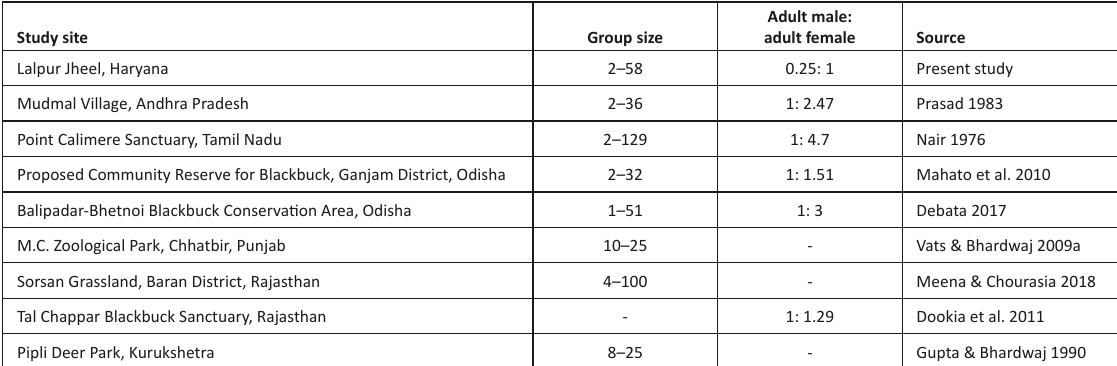
Table 5. Group size and sex ratio of Blackbuck Antilope cervicapra (Linnaeus, 1758) from protected areas of India. Study